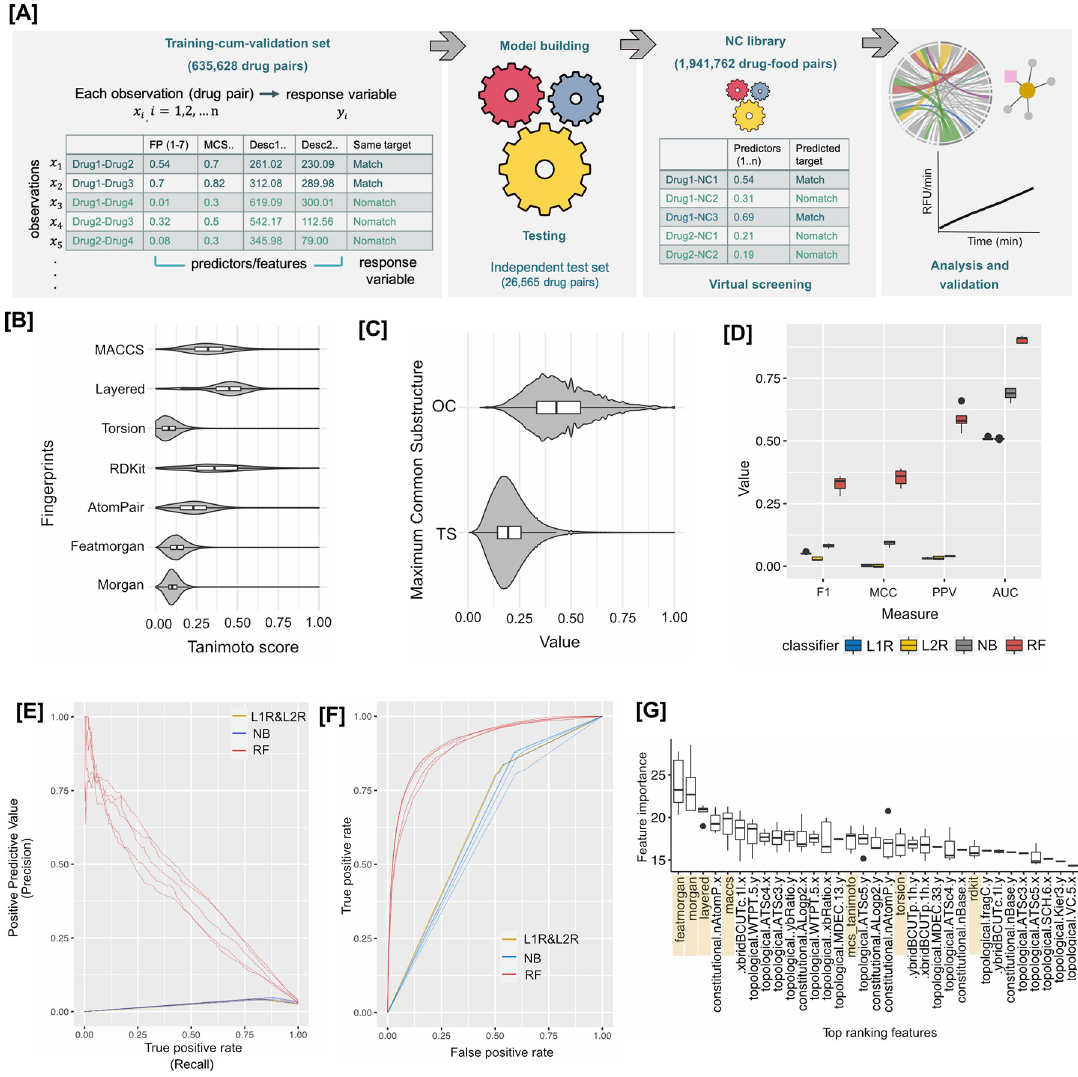
tested on an independent test set for performance evaluation. The natural compound library paired with drugs was virtually screened to obtain hit pairs, followed by analysis and in-vitro validation. (B-C)— Similarity metrics (ML dataset) . (B) Molecular fingerprints—the 7 fingerprints generate a different similarity score for the pairs of drug molecules compared. The median value of each is represented in the box plot (in the center) and the spread shows the density of the drug pairs around that score. (C) MCS—there are two types of scores reported by the MCS algorithm, one is the Tanimoto score and the other is the Overlap coefficient (OC). The violin plots were smoothed for density by an adjustment factor of 3. (D-F)— Performance on the test set. (D) performance of the four models, viz., regularized logistic regression (L1R and L2R), na ï ve bayes (NB) and random forest (RF) on independent test set for all 5 split-sets. Performance was evaluated using balanced measures: F1 score, matthews correlation coefficient (MCC), positive predictive value (PPV) and area under the curve (AUC). RF clearly had higher performance as compared to the logistic regression and na ï ve bayes models under all metrics and data splits. The performance of all models was also evaluated using (E) precision-recall and (F) ROC curve–the RF models achieved an AUC of 0.90 averaged on the all 5 test-split sets whereas NB and LRs performed relatively poor on all split-sets (average: NB: 0.68, L1R: 0.51 and L2R: 0.50). (G) High ranking features of RF models on the 5 split-sets–top features are displayed, showing most of the distance-based features provided maximum information gain with ‘Featmorgan’ performing